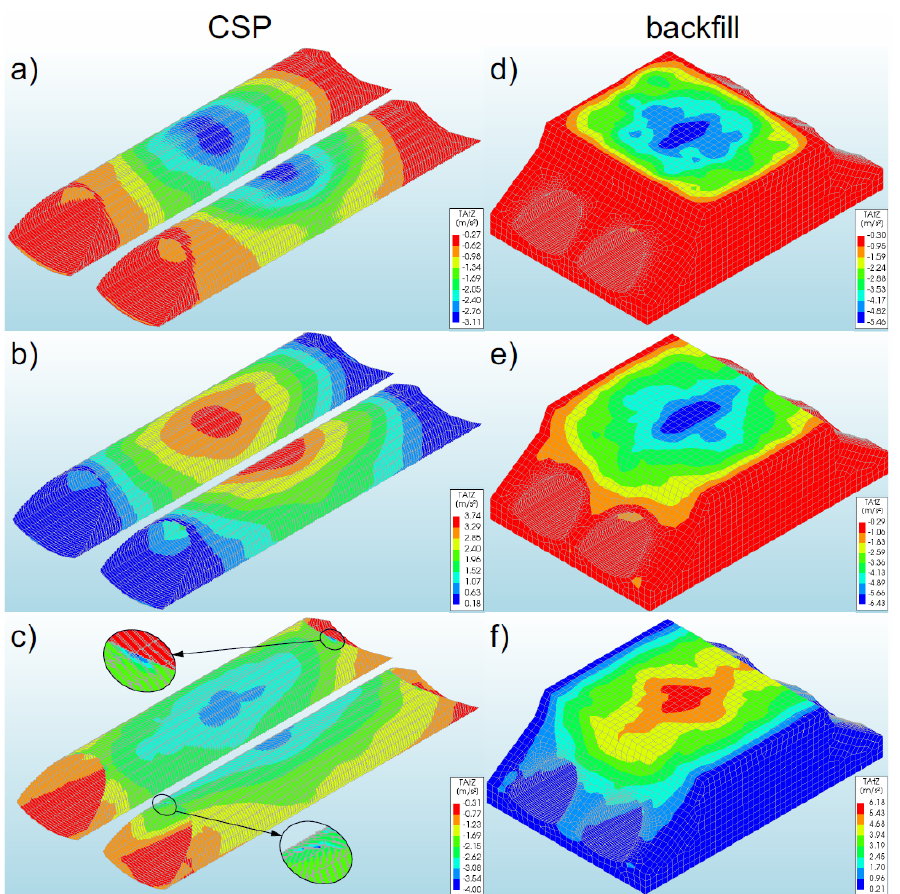
Figure 21. Maximum accelerations for bridge #II in the steel shell and backfill for model 4 ( a , d ), model 5 ( b , e ), and model 6 ( c , f ).